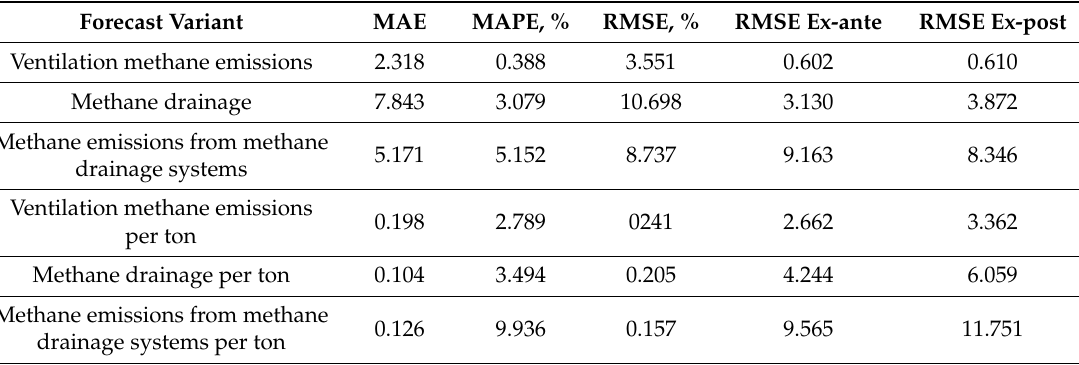
Table 6. Summary of errors.